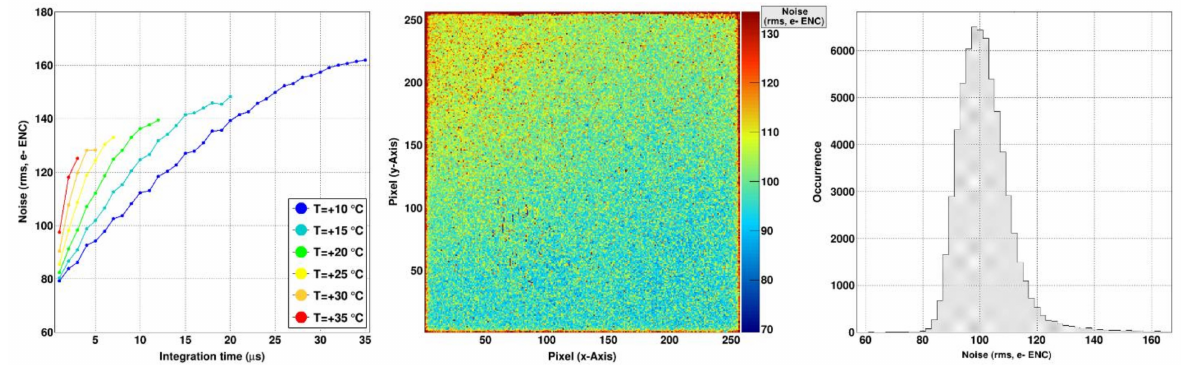
Figure 4. ( left ) Noise performance of the GaAs:Cr (2017) sensor biased at –300 V for various integration times and tempera- tures. ( middle / right ) Map and distribution of the noise performance at the typical opera-tion parameters (T = +15 ◦ C and tint= 5 µ s). The mean noise performance is (101.65 ± 0.04) e- ENC with a dis-persion of